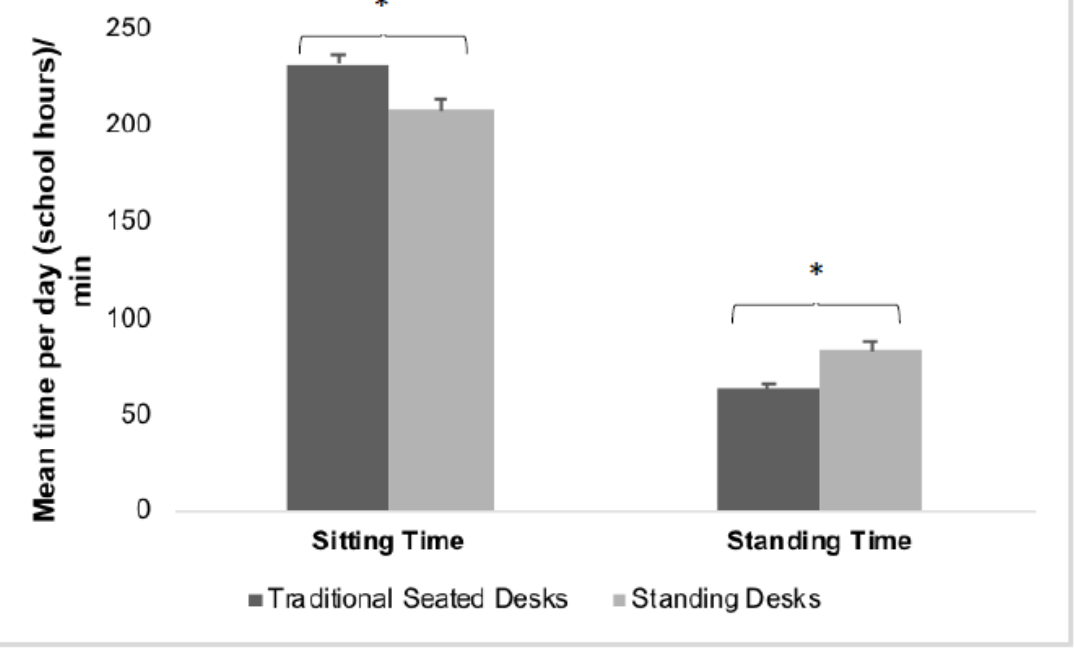
Figure 1. Comparison of mean (standard deviation (SD)) sitting and standing time between standing desk and seated desk conditions during school time. Note: * = p < 0.05 (significant difference between conditions).